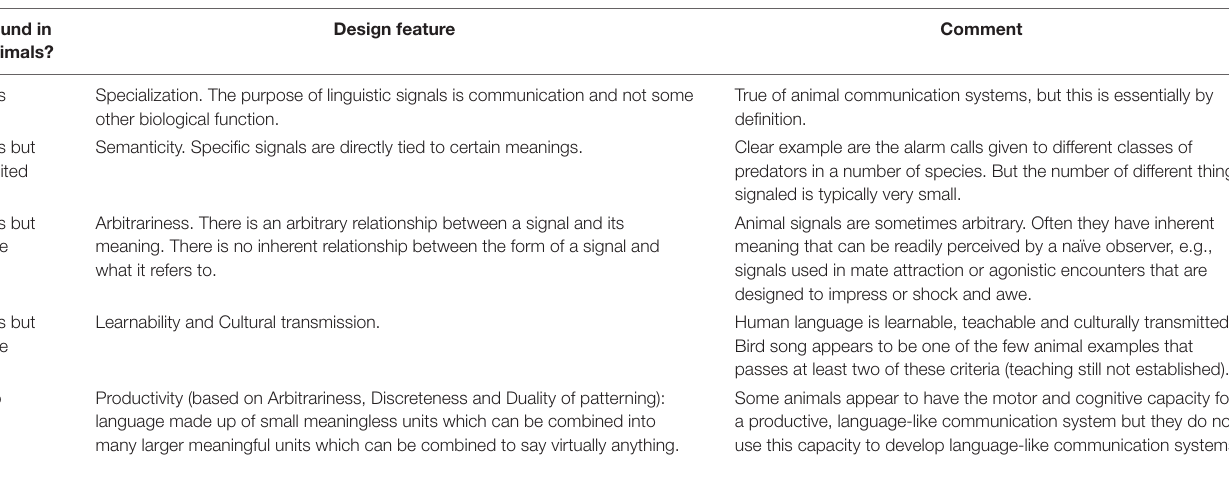
TABLE 1 | Key design features of communication systems (after Hockett, 1960, pruned and combined). Found in